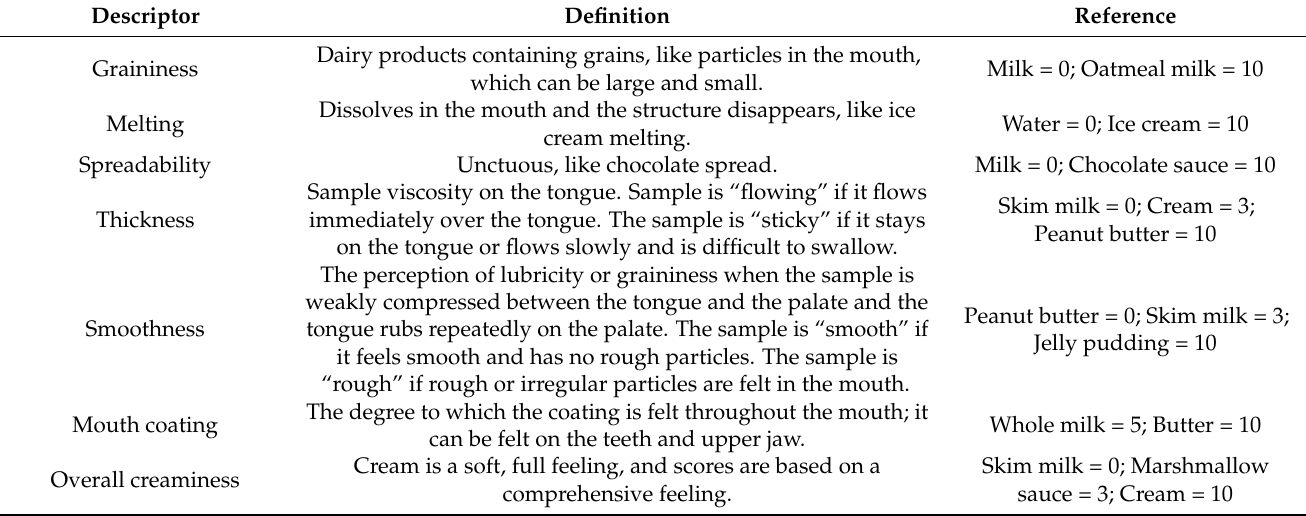
Table 2. The sensory attribute list and evaluation criteria of quantitative descriptive analysis of acid milk